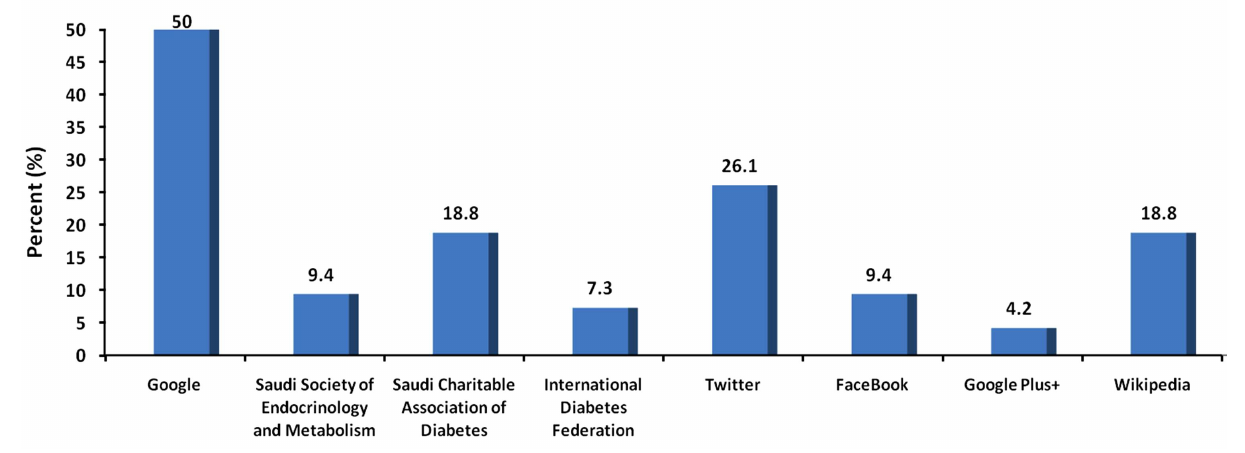
Figure 4. Types and frequency of Internet sites visited by diabetes patients to search for health-related